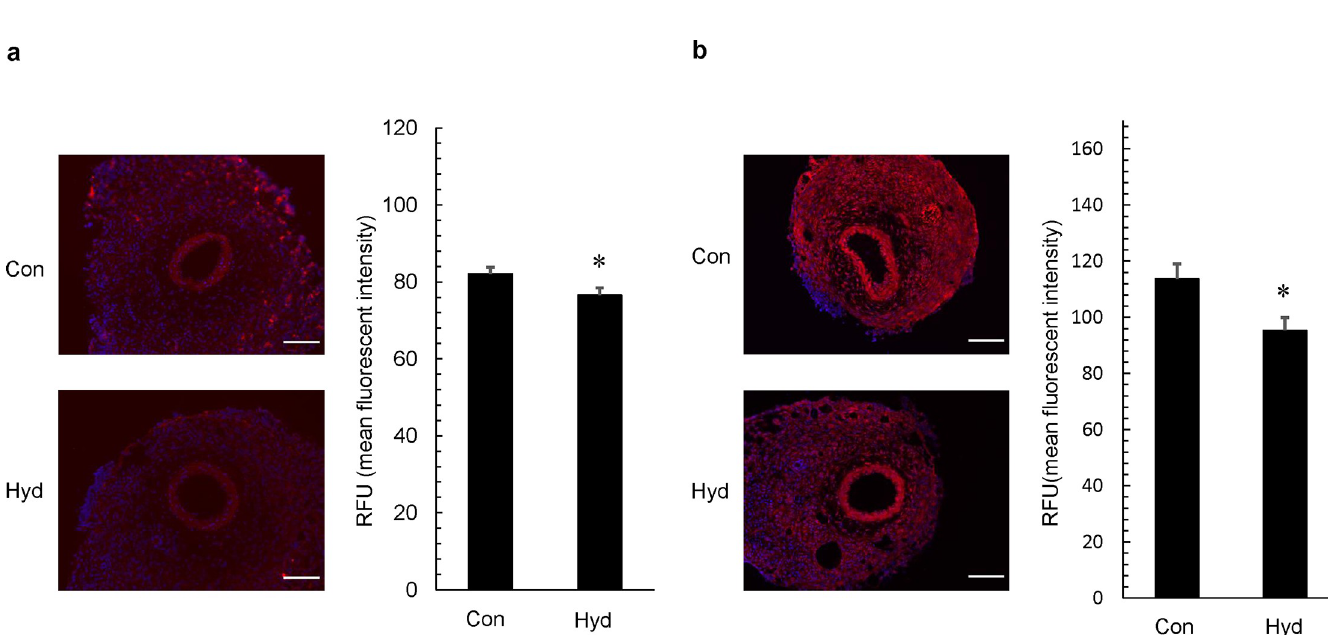
Fig 6. Effect of hydrogen gas on DNA damage by ROS. Tissue samples were prepared from cuffed arteries 7 days after operation. (A) Representative photos of cross- sections of injured femoral artery after immunohistochemical staining with anti-nitroguanidine antibody and fluorescence intensity in intima and media. The original photos were obtained as 8-bit images (original magnification × 200; scale bar: 100 μ m), and data represent relative fluorescence units (RFU). Values are mean ± SEM (n = 21 for air group (Con), n = 21 for hydrogen group (Hyd)). � p < 0.05 vs. Con.